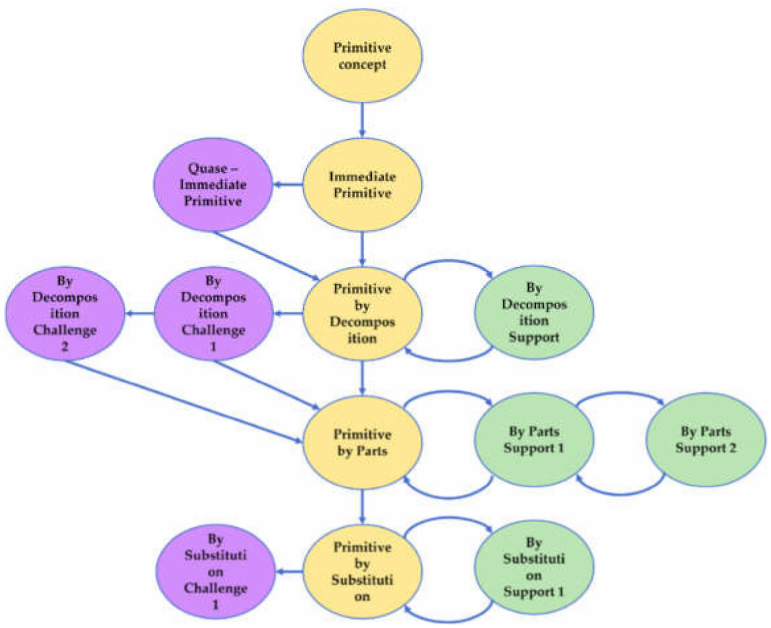
Figure 1. A learning graph on the topics primitives and